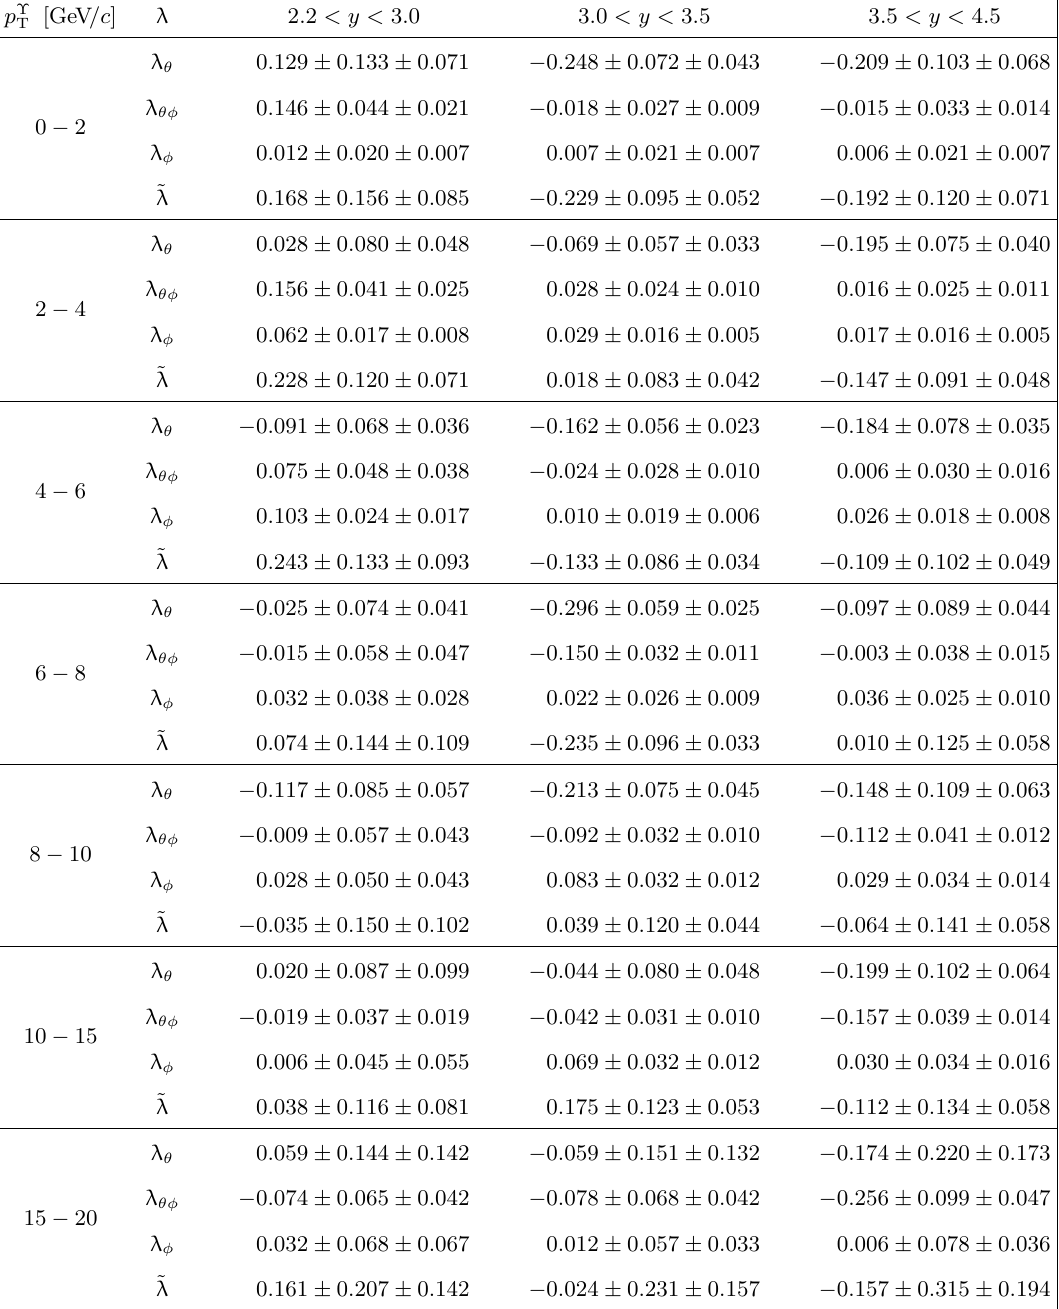
Table 15 . Values of (cid:21) (cid:18) , (cid:21) (cid:18)(cid:30) , (cid:21) (cid:30) and ~ (cid:21) measured in the GJ frame for the (cid:7)(2S) produced at p s = 7 TeV. The (cid:12)rst uncertainty is statistical and the second